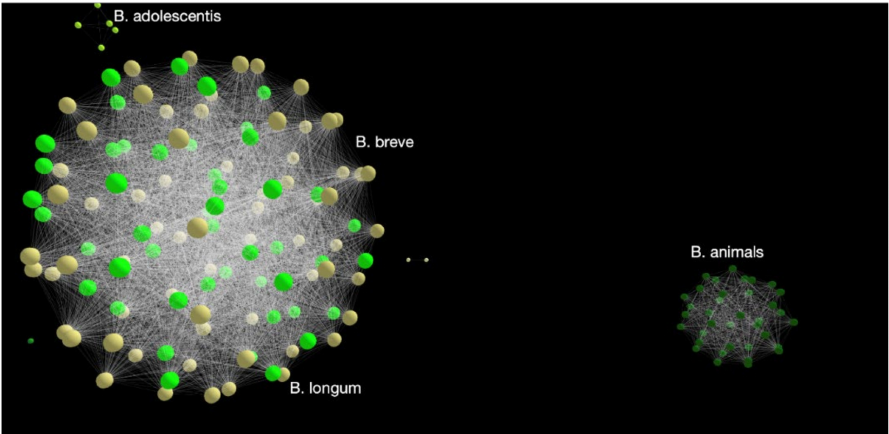
Figure 5. Example of genetic map of a subset of Lactobacillus species.